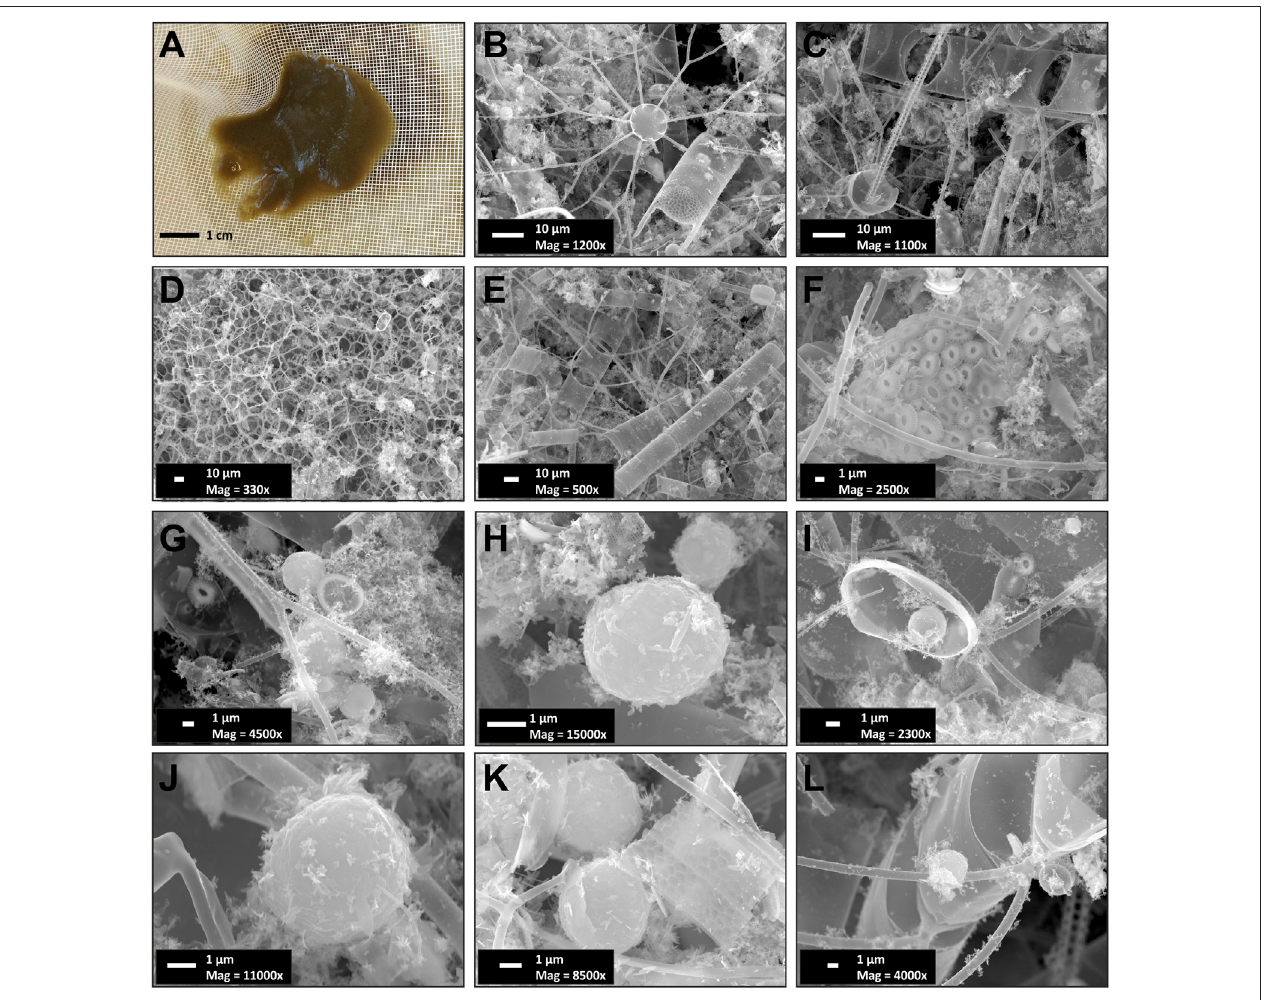
FIGURE12| Compositeof (A) samplelabprocessingphotoand (B-l) scanningelectronmicroscopy(SEM)micrographsofsinkingparticlescollectedinApril2012 (REDII-11) in the deep Ierapetra Basin. Images reveal the abundant presence of well-preserved diatoms ( B – E , e.g., Chaetoceros spp. and Thalassioria spp.), and coccolithophores (F) as well as ash microspherules (G – L) . Mag: Magni fi cation (see more details in Pedrosa-Pàmies et al., 2016).